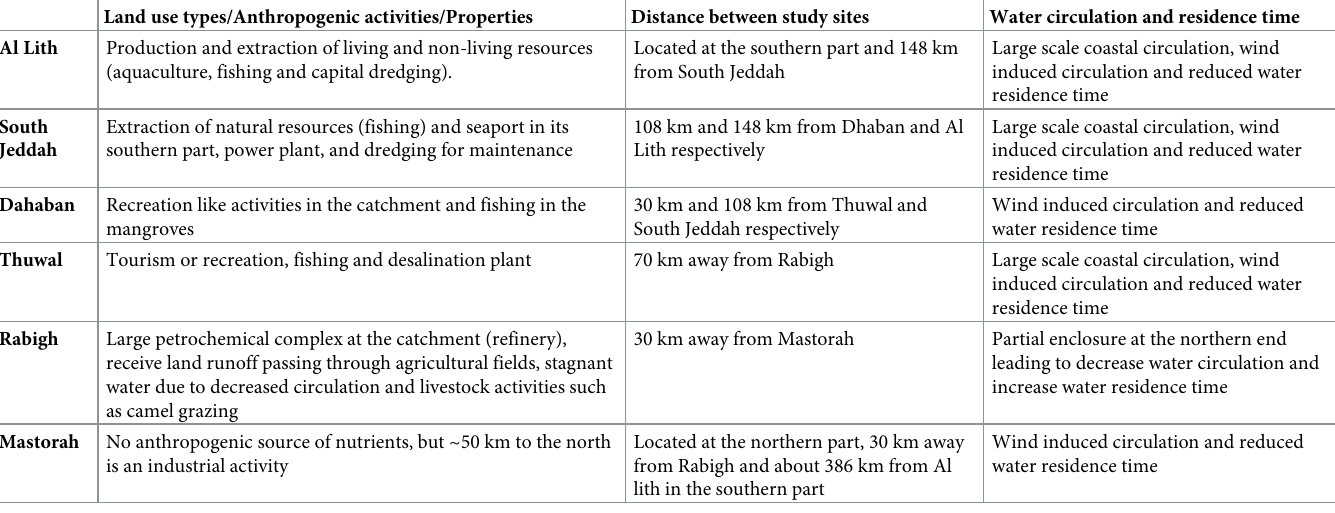
Table 1. Study sites in Saudi Arabia Red Sea with water circulation and residence time characteristics and potential causes and sources of anthropogenic